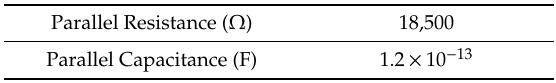
Table 2. Electric properties of the dielectrophoretic